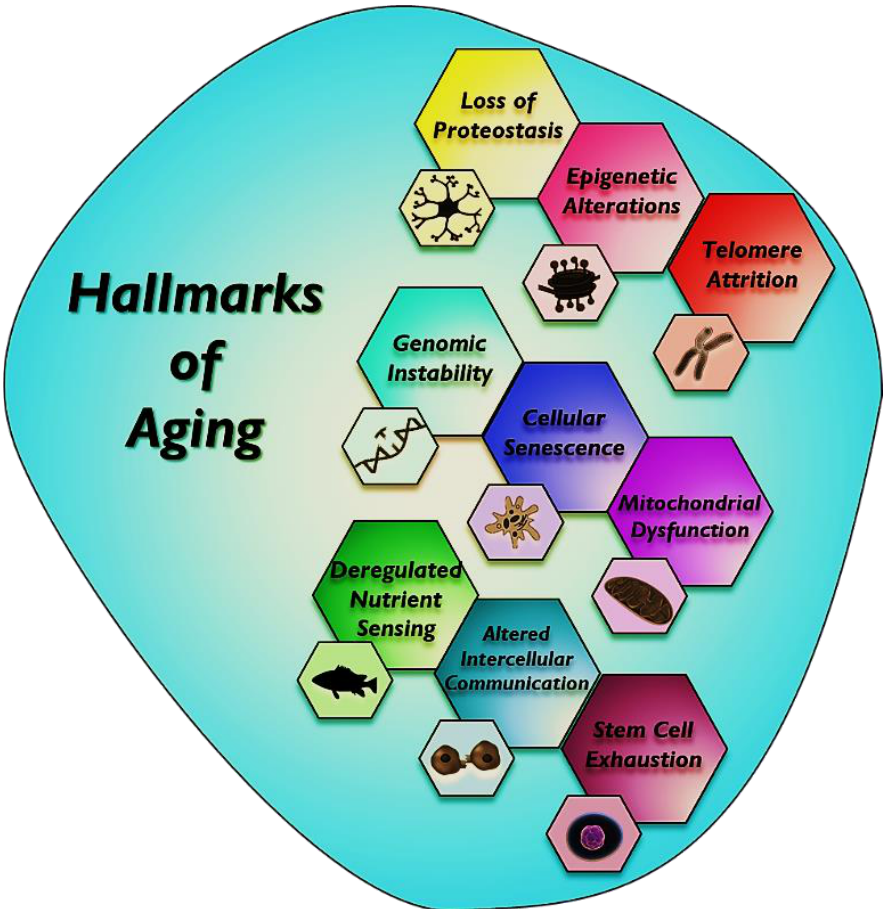
Figure 1. Hallmarks of aging. This scheme identifies the nine hallmarks briefly described in this review: loss of proteostasis, epigenetic alterations, telomere attrition, genomic instability, cellular senescence, mitochondrial dysfunction, deregulated nutrient sensing, altered intercellular communication, and stem cell exhaustion.